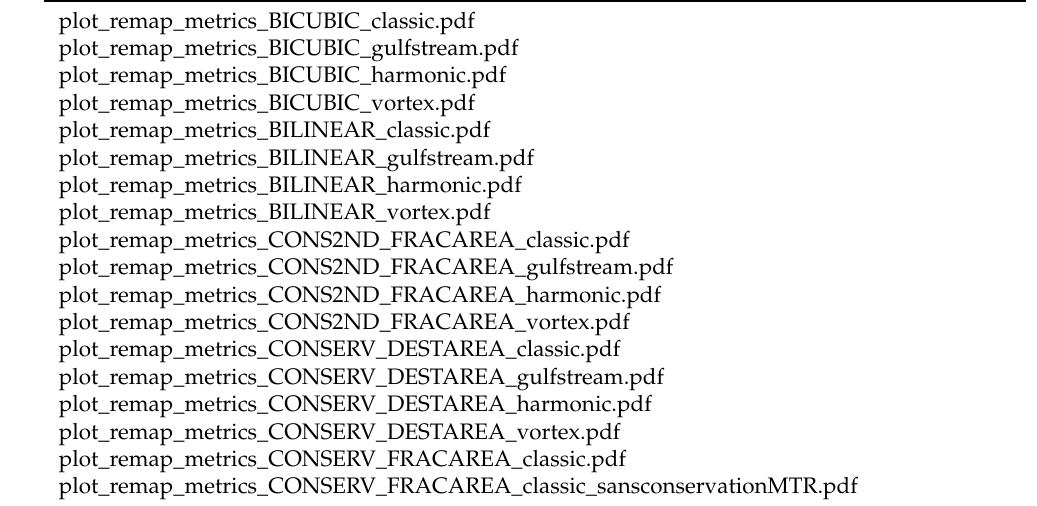
Table A2. Regridding benchmark plots included in the tar file